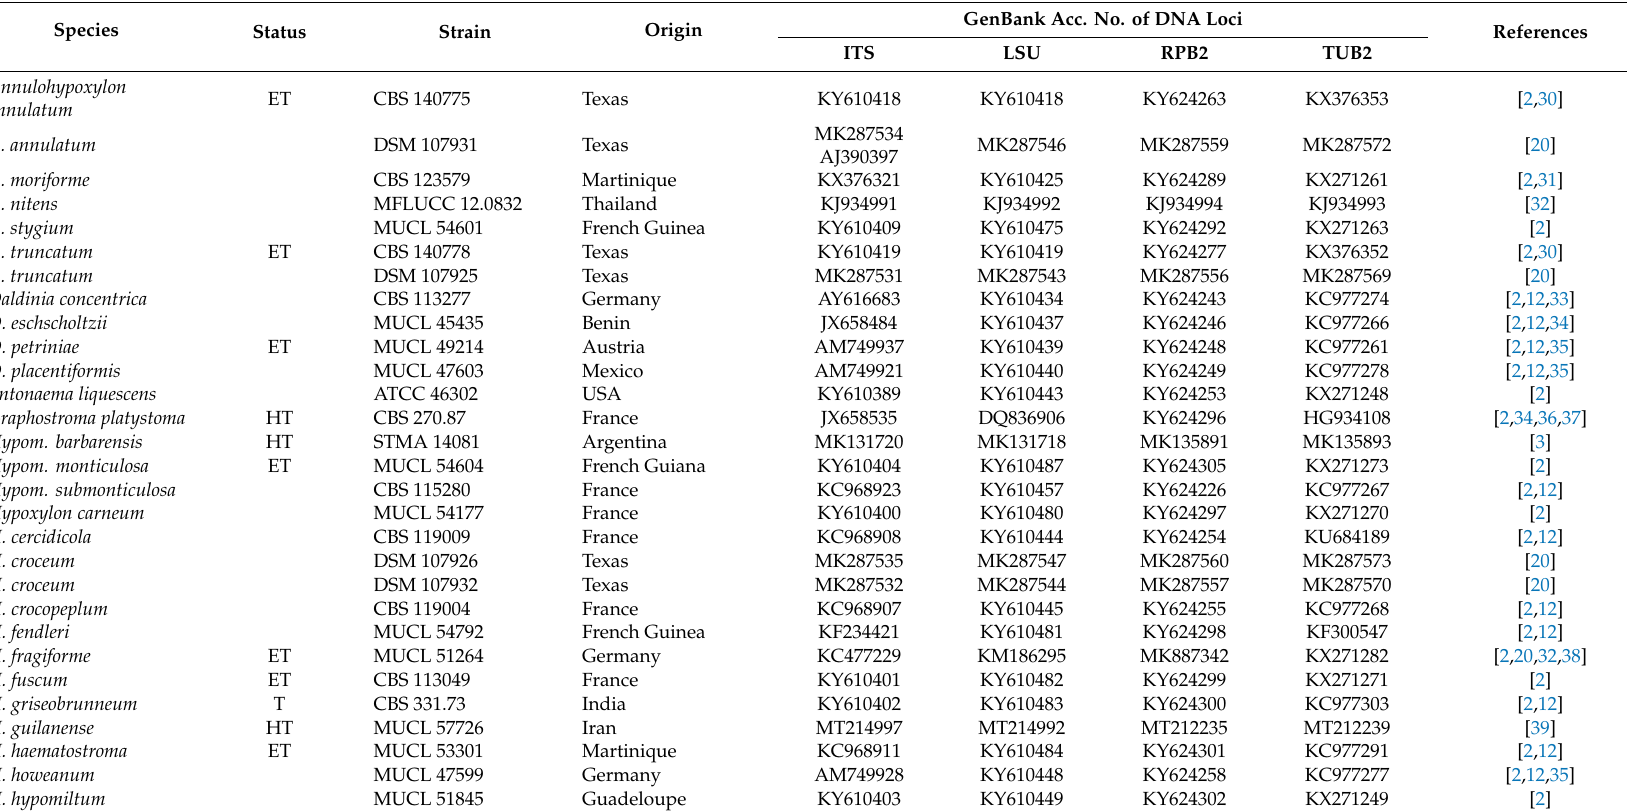
Table 1. Sequence accession numbers, corresponding isolates, and literature reference of sequences used for the molecular phylogenetic inference. Species-type specimen are given the corresponding label (HT = holotype; ET = Epitype). The newly sequenced H. invadens isolate is highlighted in